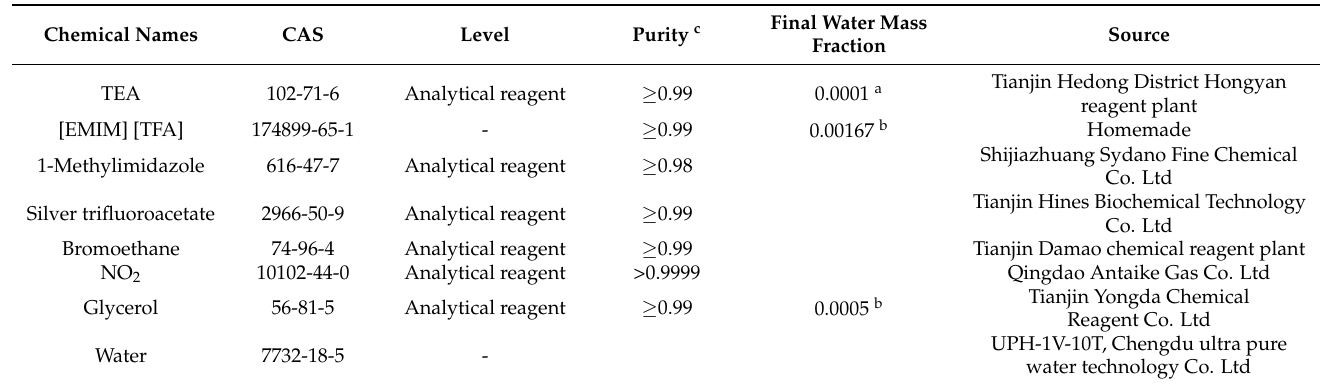
Table 9. Sample purity description.